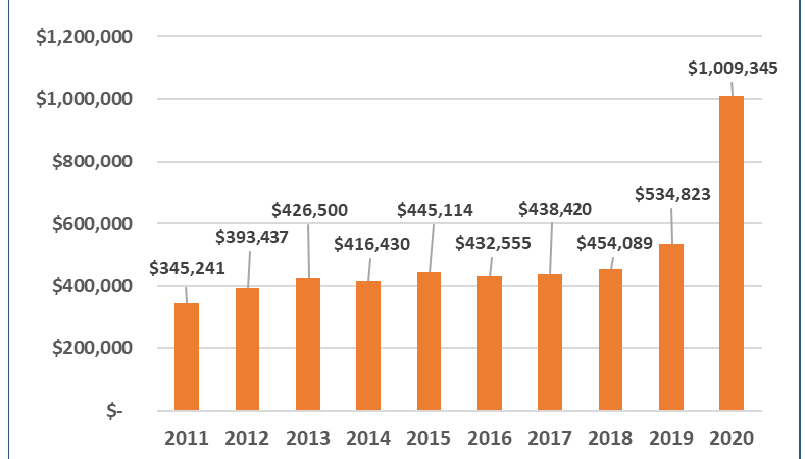
Figure 1. Annual Food Sales at Local Roots, All Food